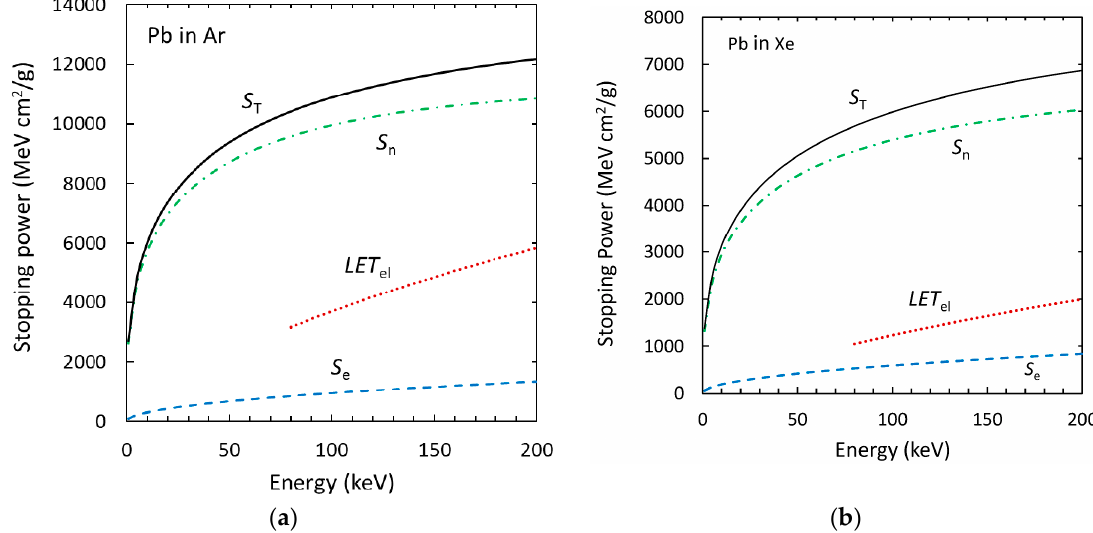
Figure 2. The stopping powers and the electronic LET for Pb ions: ( a ) in argon; ( b ) in xenon. LET el was obtained by using a semi-empirical power-law approximation for q nc .